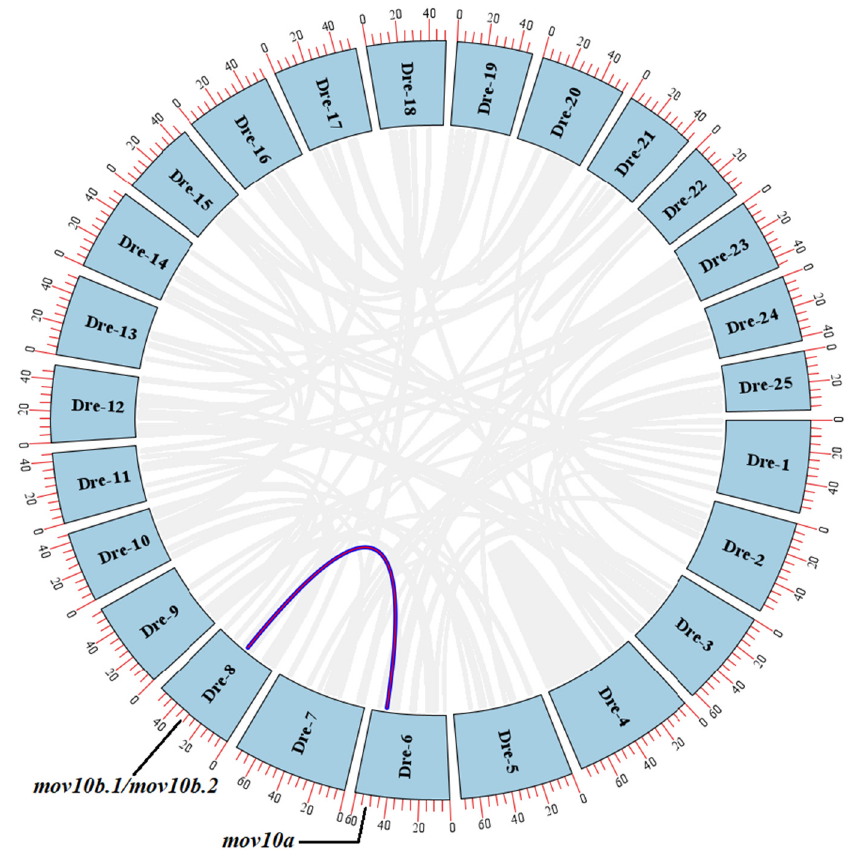
Figure 5. The circos plot of mov10s in zebrafish inter-chromosomal synteny analyses. The blue boxes represent the numbered zebrafish chromosomes. The outer red scales indicate the lengths of the chromosome sequences, with each scale representing 5 MB. The gray lines inside between the two chromosomes indicate the homologies between the genes, while the other colored lines indicated them between mov10s . Dre, Danio rerio .